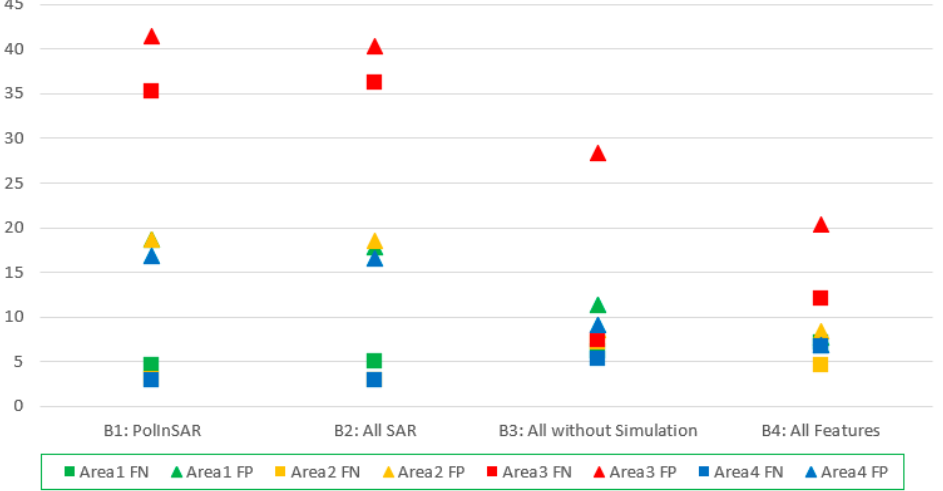
Table 10 . The performance measurements True Positive (TP), True Negative (TN), False Positive (FP), and False Negative (FN) associated with the highest accuracies achieved using selected features in A category for all four AOIs as highlighted in Table 8.